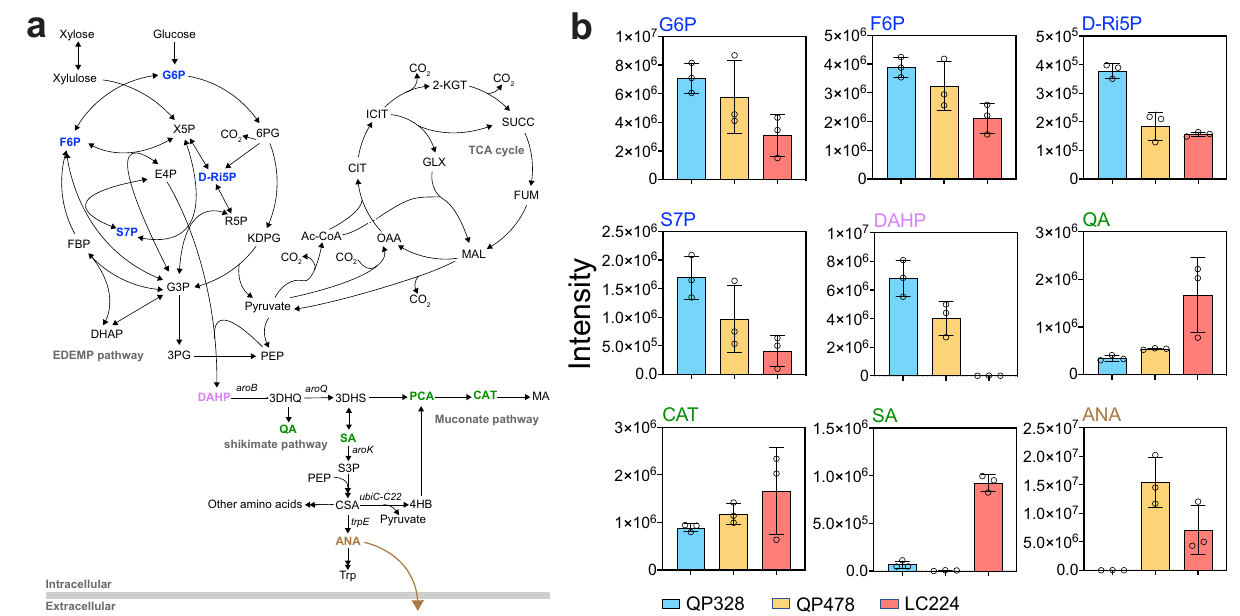
Fig. 6 | Selected intracellular and extracellular metabolomics analysis of strains grown on glucose and xylose. a Simpli fi ed metabolic pathway. Meta- bolites in the EDEMP cycle are labeled blue, in the shikimate and muconate pathway are labeled green, the joint node DAHP is labeled purple, the extracellular anthranilic acid (ANA) is labeled brown. QA quinic acid, ANA